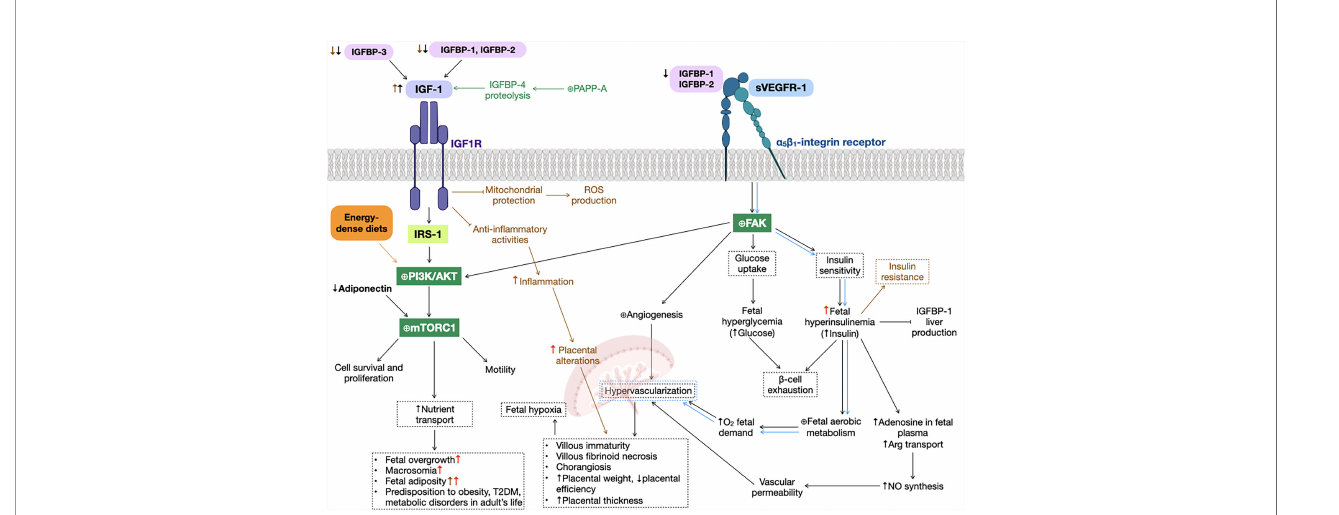
FIGURE 1 | Gestational diabetes mellitus (GDM) alterations in insulin-like growth factor 1 (IGF-1) signaling pathway. GDM (black arrows) and preeclampsia (green text and arrows) reduce insulin-like growth factor binding protein 1 (IGFBP-1) levels, increasing IGF-1 bioavailability, that promotes phosphatidylinositol-3-kinase (PI3K)/protein kinase B (AKT) cascade (as well as energy-dense diets, orange text and arrows), activating mammalian target of rapamycin complex 1 (mTORC1), that results in cell survival and proliferation, motility and an augment nutrient transport, leading to fetal overgrowth, macrosomia, fetal adiposity, type 2 diabetes mellitus (T2DM), metabolic disorders and predisposition to obesity in adult life. Additionally, soluble form of the vascular endothelial growth factor receptor 1 (sVEGFR-1) can bind to a 5 b 1 -integrin receptor (blue arrows), expressed predominantly in extravillous trophoblasts, activating the focal adhesion kinase (FAK), promoting fetal hyperglycemia and hyperinsulinemia, that lead to b -cell exhaustion, a principal characteristic of GDM. This increase in insulin levels cause promote nitric oxide (NO) synthesis and fetal aerobic metabolism, both producing hypervascularization in the placenta, that could result in several physiological alterations in this organ, such as villous immaturity, villous fi broid necrosis, chorangiosis, increased placental weight and thickness, and decreased placental ef fi ciency. Also, FAK activation is involved in angiogenesis in several organs, e.g. , the placenta. Obesity before and/or during pregnancy (brown text and arrows) inhibit IGF-1 anti-in fl ammatory and mitochondrial protection activities, resulting in an increase in in fl ammation, ROS production and, hence, placental alterations. High-dense diets (red arrows) exacerbate GDM alterations, such as fetal overgrowth, macrosomia, fetal adiposity, in fl ammation, placental alterations and predisposition to disorders in adult ’ s life. ⊕ means enhancing protein